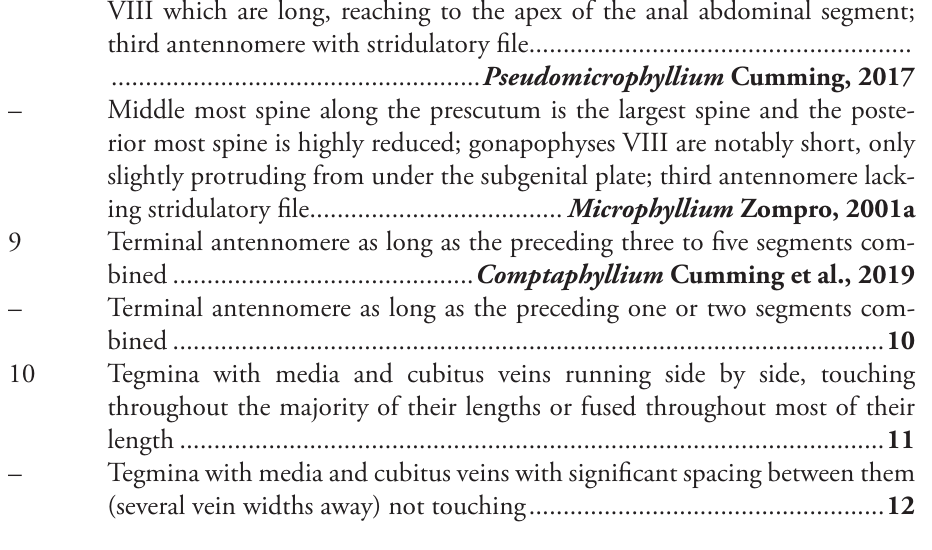
Protibiae exterior with two lobes (one on the distal end and one closer to the – Protibiae exterior simple (lacking lobes) or with a singular lobe that can be present partially on the distal portion only or fully spanning the shaft ........ 6 5 Gonapophyses VIII average in length, with a majority of their length under the terminal abdominal segment, only the tips project from the apex; tegmina venation has the radius and the media diverging immediately, not running parallel for any portion of their lengths; tegmina venation has a distinct ra- – Gonapophyses VIII long, with ca. half of their length projecting from under the terminal abdominal segment; tegmina venation has the radius running alongside the media until the radial sector arcs away; tegmina venation, no 6 Pro-, meso-, and metatibiae exterior with lobes; and tegmina with media and cubitus veins running side by side, touching throughout most of their – Pro-, meso-, and meatibiae simple, lacking exterior lobes (but if exterior lobes are present they are usually only partially present only on the distal portion or very rarely fully spanning the shaft (in which case the tegmina media and cu- bitus veins are distinctly separated with several vein width distances between them throughout the length, not touching)) ............................................... 7 7 Prescutum spination along the sagittal plane with the middle or posterior spine the most prominent (therefore not equal in size the other spines) ...... 8 – Prescutum sagittal plane either with: the spine on the anterior rim most prominent, an anterior rim followed by granulation, or with spination of equal size from the anterior to the posterior (no single spine notably more prominent than the others) ......................................................................... 9 8 Posterior most spine of the prescutum is the most prominent; gonapophyses VIII which are long, reaching to the apex of the anal abdominal segment;